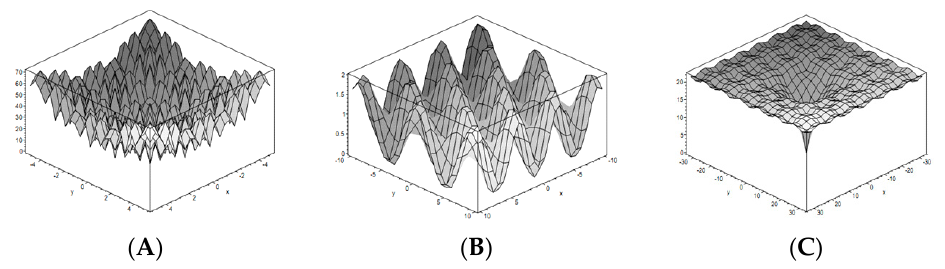
Figure 5. Benchmark functions ( A ) Rastrigin, ( B ) Ackley, and ( C ) Griewang.